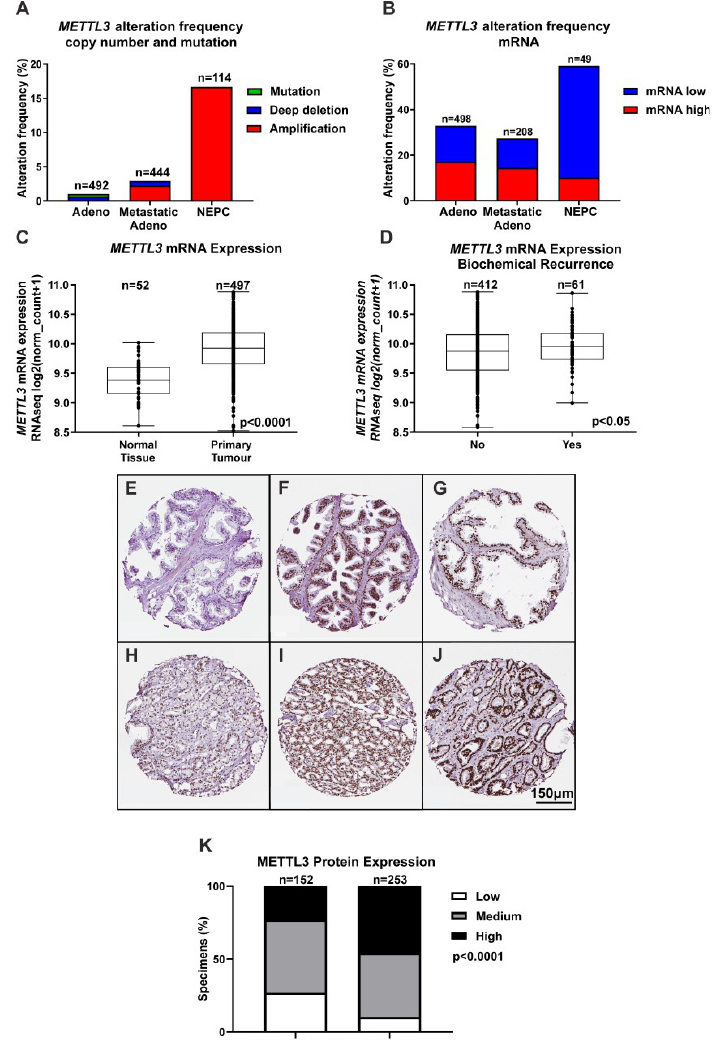
Figure 1. METTL3 expression in PCa patients. Bioinformatic analysis using multiple PCa